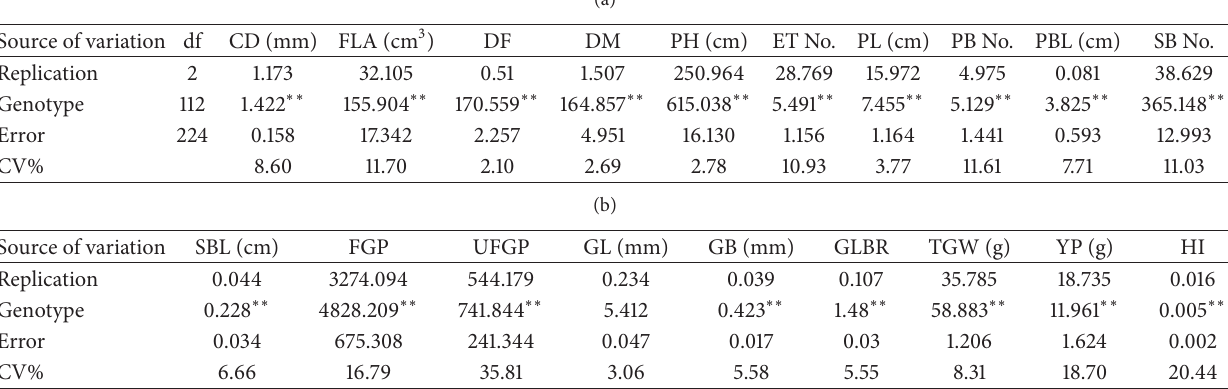
Table 3: Analysis of variance for different quantitative characters in 113 aromatic and fine rice genotypes. (a)